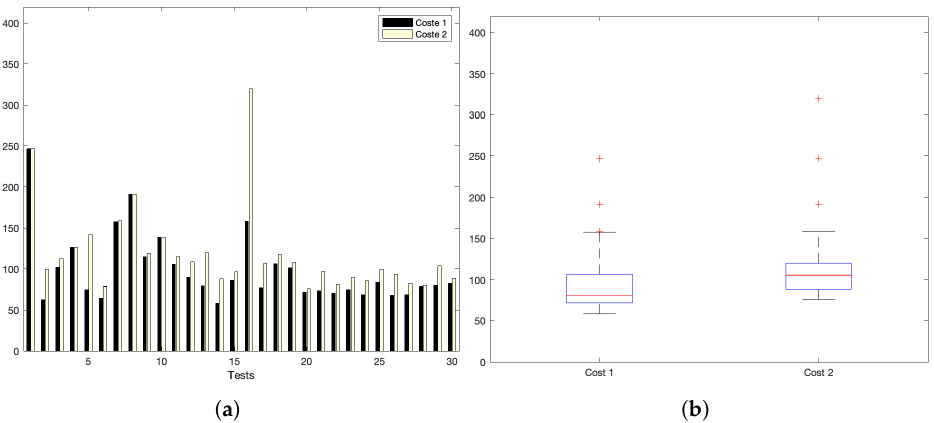
Figure 10. Low request burst-rate. ( a ) Individual test values for cost 1 and cost 2 . ( b ) Summary of costs.